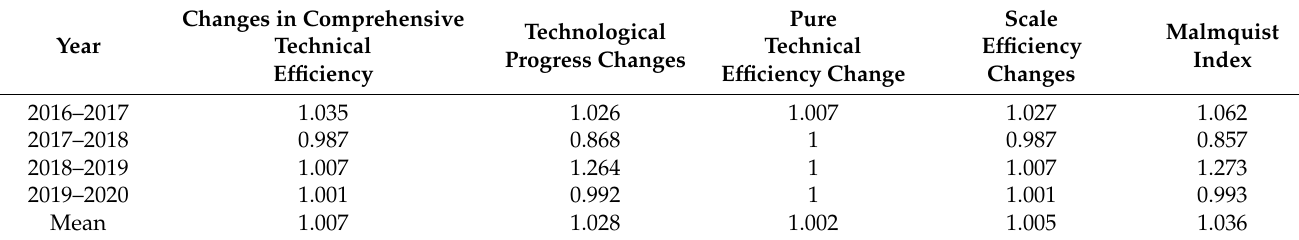
Table 7. Changes in the Malmquist Index and decomposition items in each year.